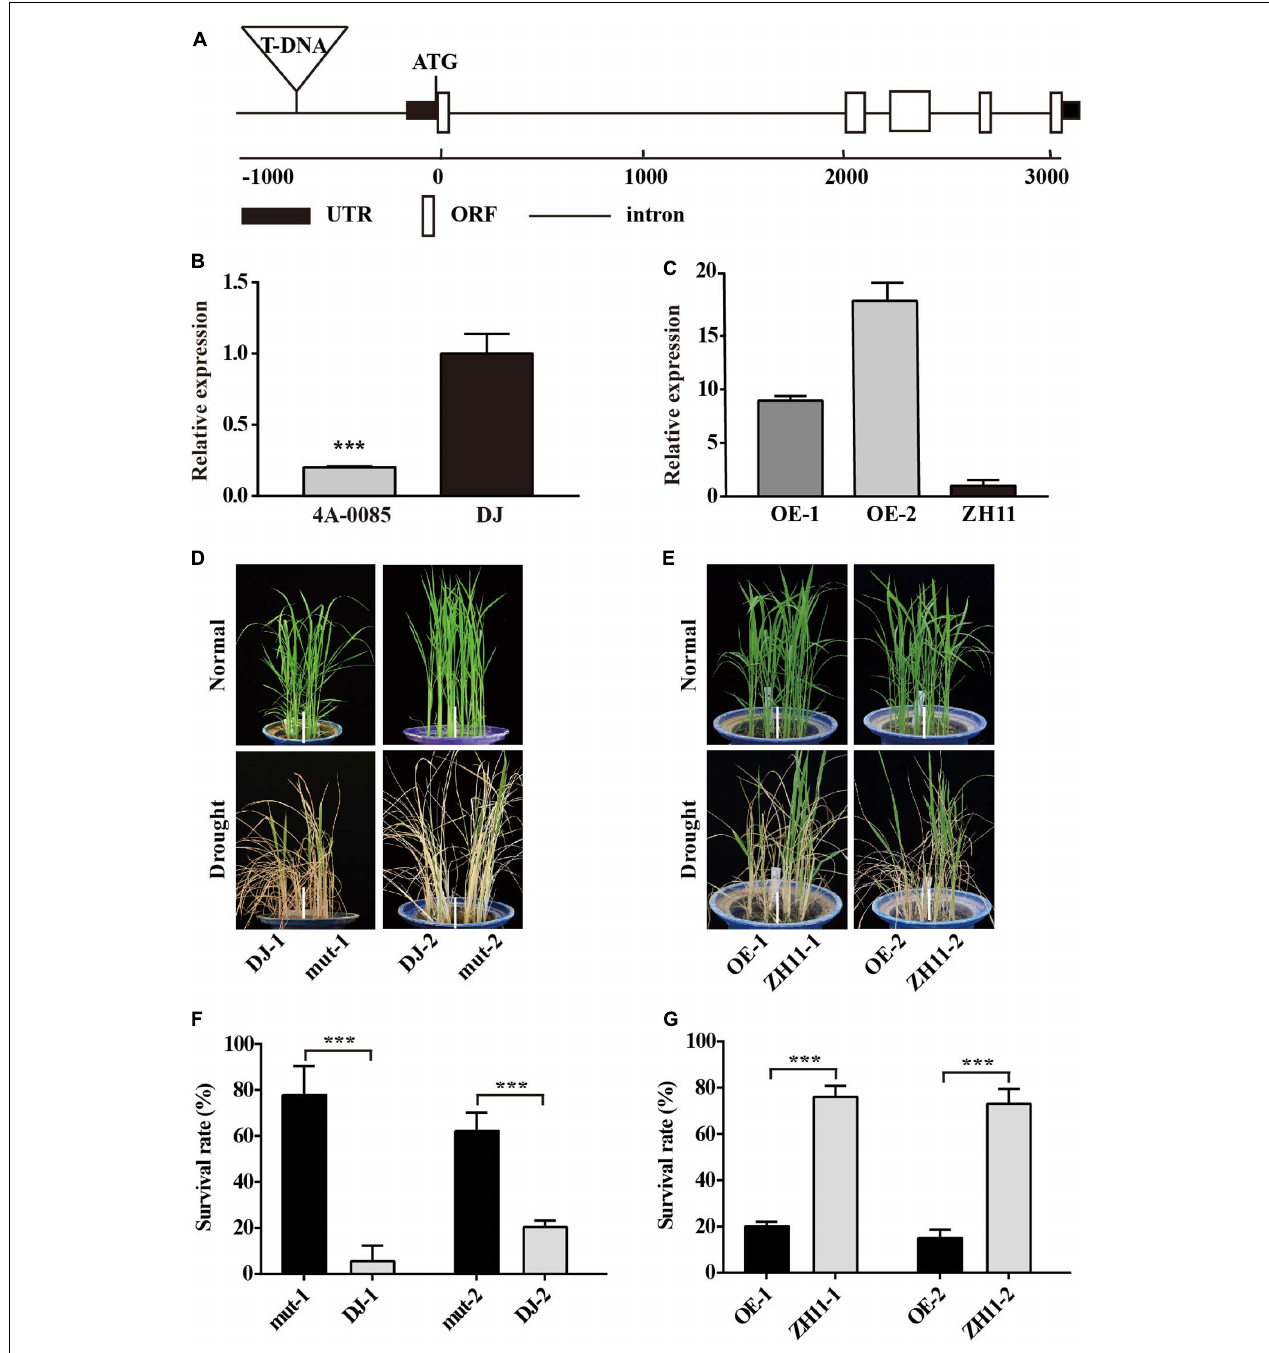
FIGURE 2 | Phenotypes of the OsJAZ1 -OE plants and the jaz1 T-DNA insertion mutant plants under drought stress treatment at the seedling stage. (A) Schematic diagram of the OsJAZ1 gene and 4A-00845 T-DNA insertion mutant. UTR, ORF, and introns are indicated in the black box, white box, and line, respectively. (B) Expression levels of OsJAZ1 in the 4A-00845 homozygous line and Dongjin. (C) The expression levels of OsJAZ1 in the OE lines and WT ZH11. (D,E) Drought tolerance testing of jaz1 T-DNA mutant plants and over-expression plants. (D) The jaz1 mutant lines showed increased drought resistance. (E) The OsJAZ1 -OE plants were more sensitive to drought stress treatment compared to WT ZH11. (F,G) The survival rates of the transgenic and WT plants after recovery from drought stress treatment for 7 days. Mut-1 and mut-2 were heterozygous mutants segregated from 4A-00845. Error bars represent the SE of three replicates ( ∗∗∗ P < 0.005, Student’s t